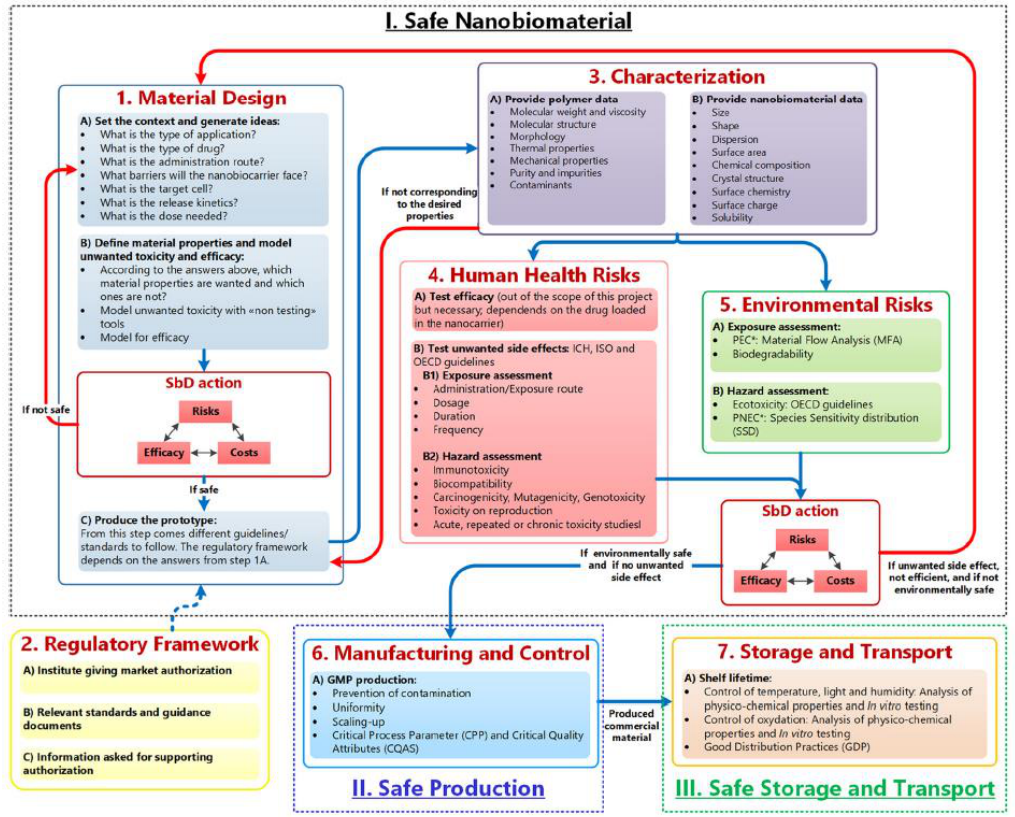
Figure 18. Safety-by-Design approach. Blue arrows correspond to the flow of polymeric nanobiomaterials as drug delivery systems from design to storage and transport, red arrows are feedback loops uses whenever the nanobiomaterial product is unsafe, inefficient or has unwanted side effects, and bullet points represent the methods/tools or endpoints at each step. Reprinted from [228]. Copyright (2020) Schmutz, Borges, Jesus, Borchard, Perale, Zinn, Sips, Soeteman-Hernandez, Wick and Som.